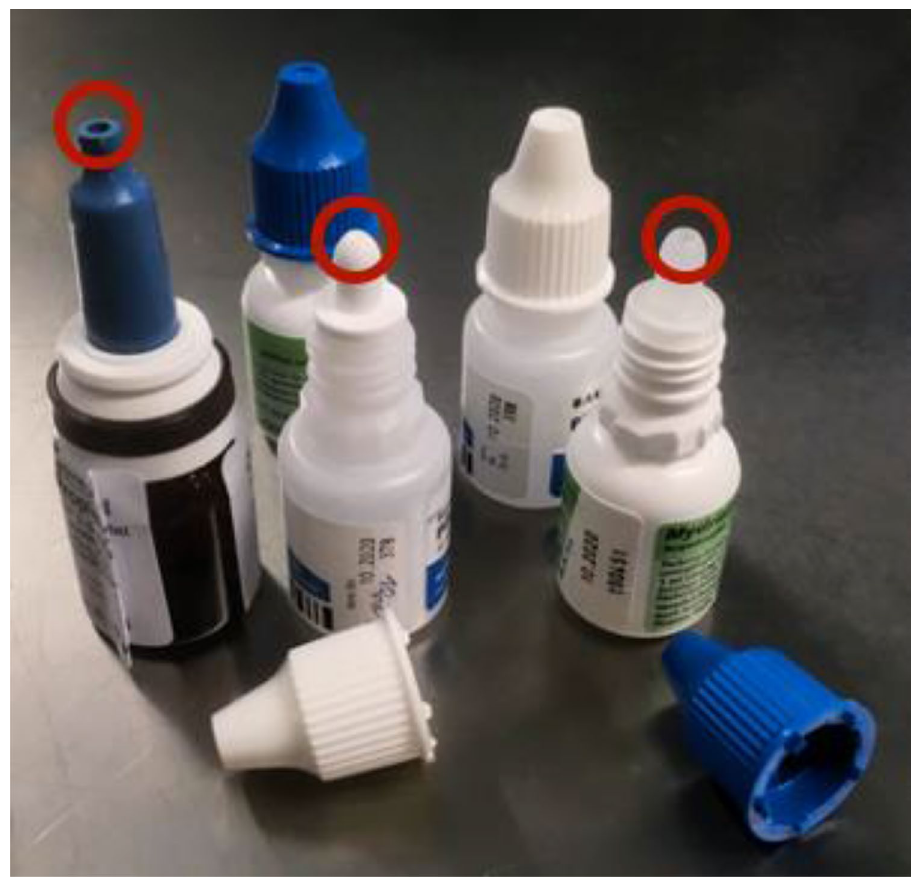
Figure 1. Examples of opened multi-dose eyedrop bottles with marked (red circle) tip of the bottle where swabs were taken (by Robert Kromer,